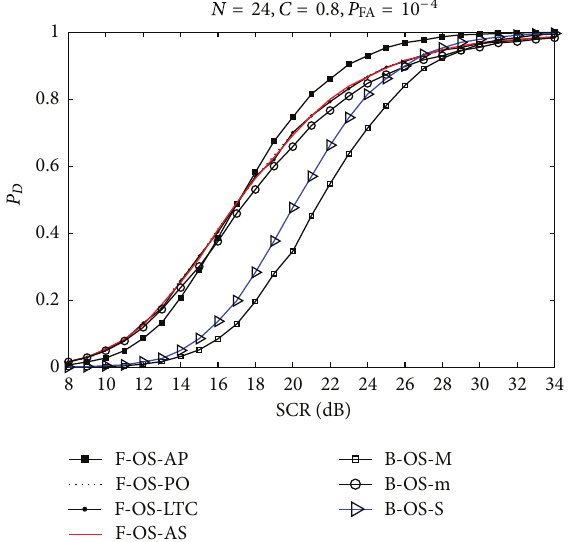
F 3: PD versus SCR performance of distributed detector based on ML CFAR algorithm in local sensors when . 𝐶𝐶 = 0.8